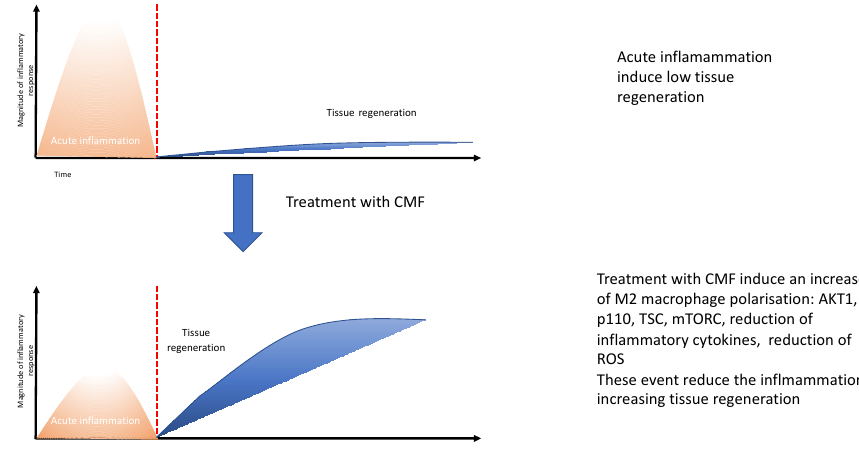
Figure 8. Conclusion of the potential effect of the CMF treatment on the wound healing